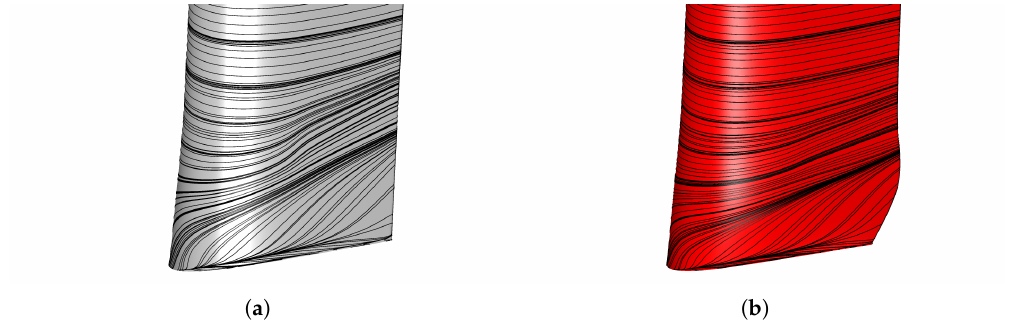
Figure 8. Boundary layer (BL) streamlines on the blade suction side at Re = 100,000 ( a ) orig blade; ( b ) snaked blade.